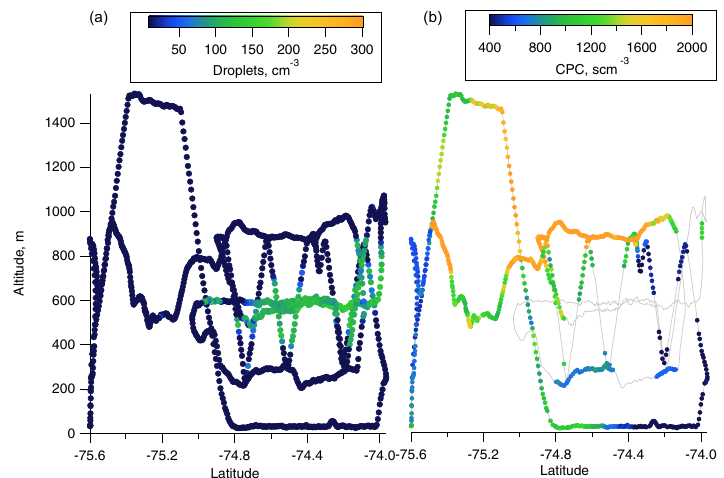
Figure 10. Latitudinal cross sections of Flight 219 coloured by droplet concentration (a) and total aerosol concentrations out of cloud (b) . Grey lines shows the flight track. These show a layer of high aerosol concentrations above the cloud top.